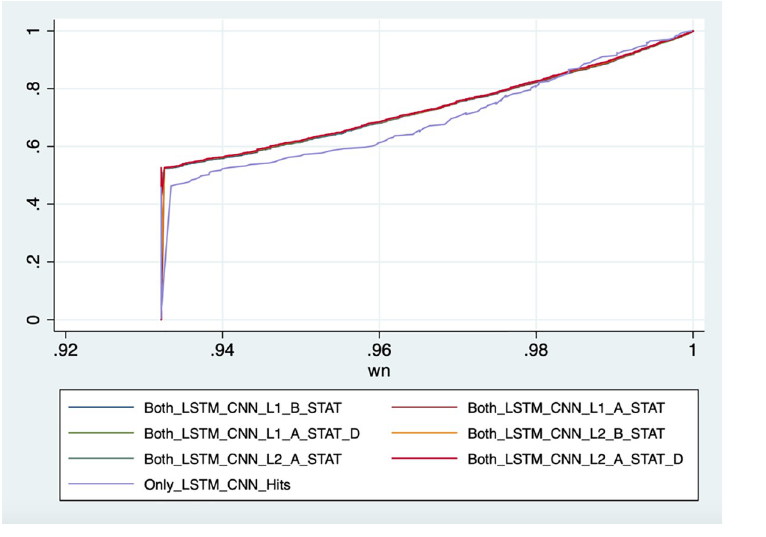
Fig 11. CDF plots of w n for sets in Table